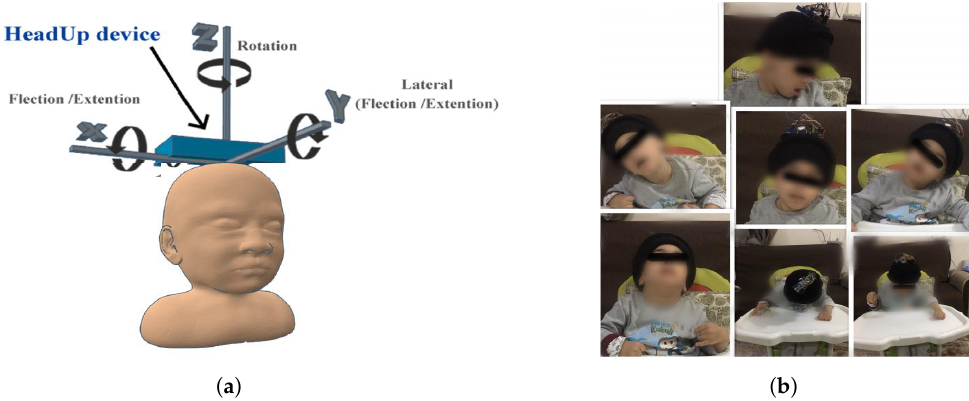
Figure 14. System implementation. ( a ) HeadUp placement. ( b ) Child with CP wearing HeadUp device.